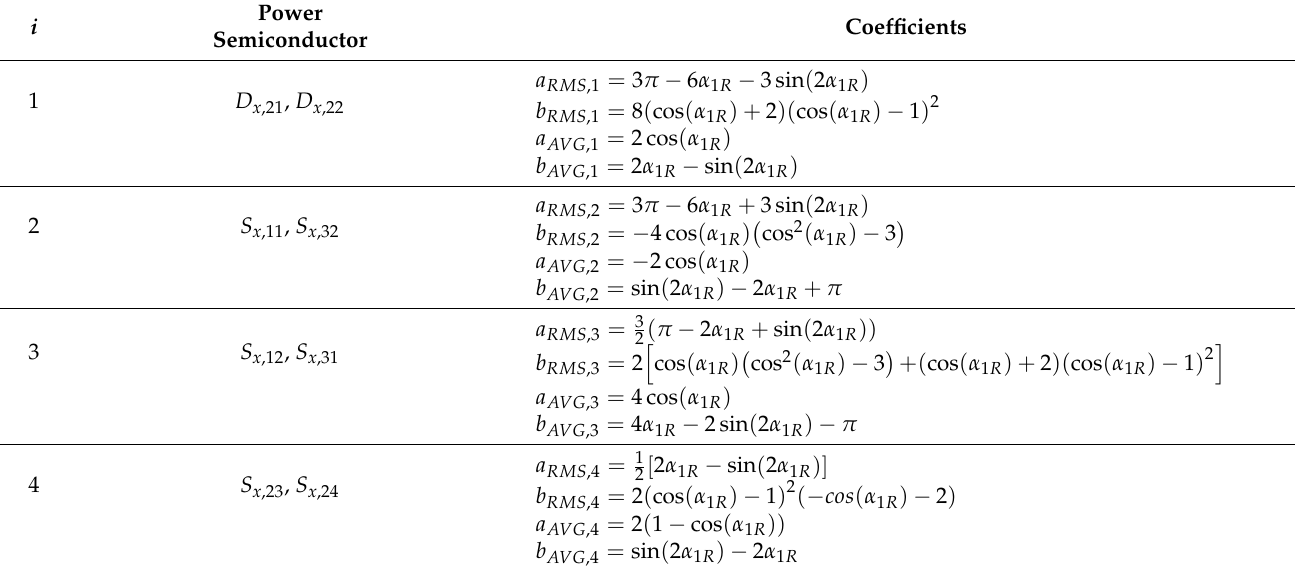
Table A1. 3 Φ 5L E-Type MMR power semiconductor coefficients of the RMS and AVG